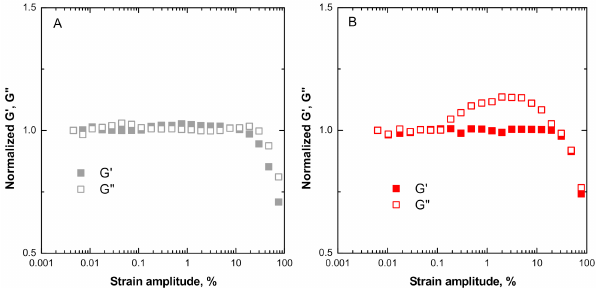
Figure 4. Large amplitude oscillatory shear (LAOS) rheological data for ( A ) pristine ENR and ( B ) ENR + SiO 2